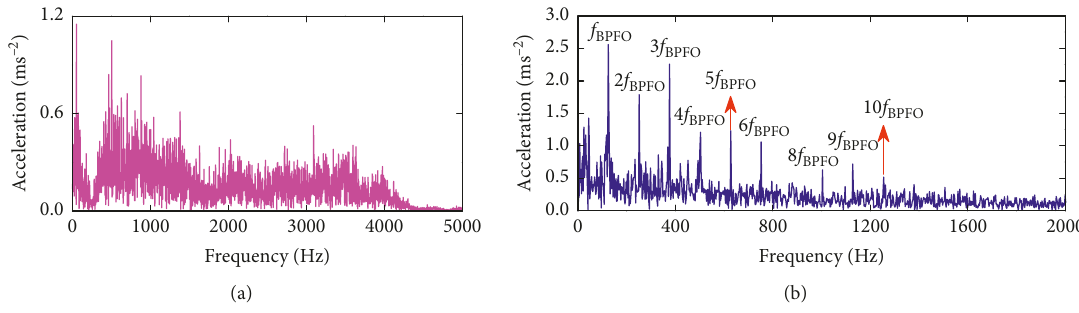
Figure 28: (a) Fourier spectra of IRS1; (b) envelope spectra of IRS1.